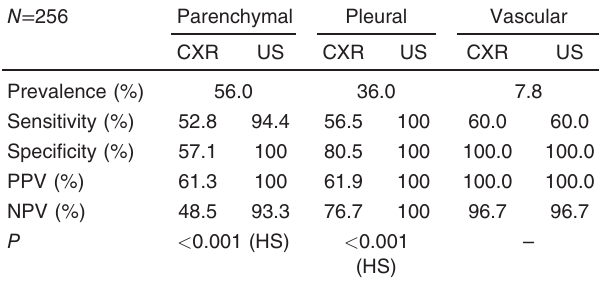
Table 6 Diagnostic performance of ultrasonography regarding the final diagnosis Diagnosis ( N = 256)